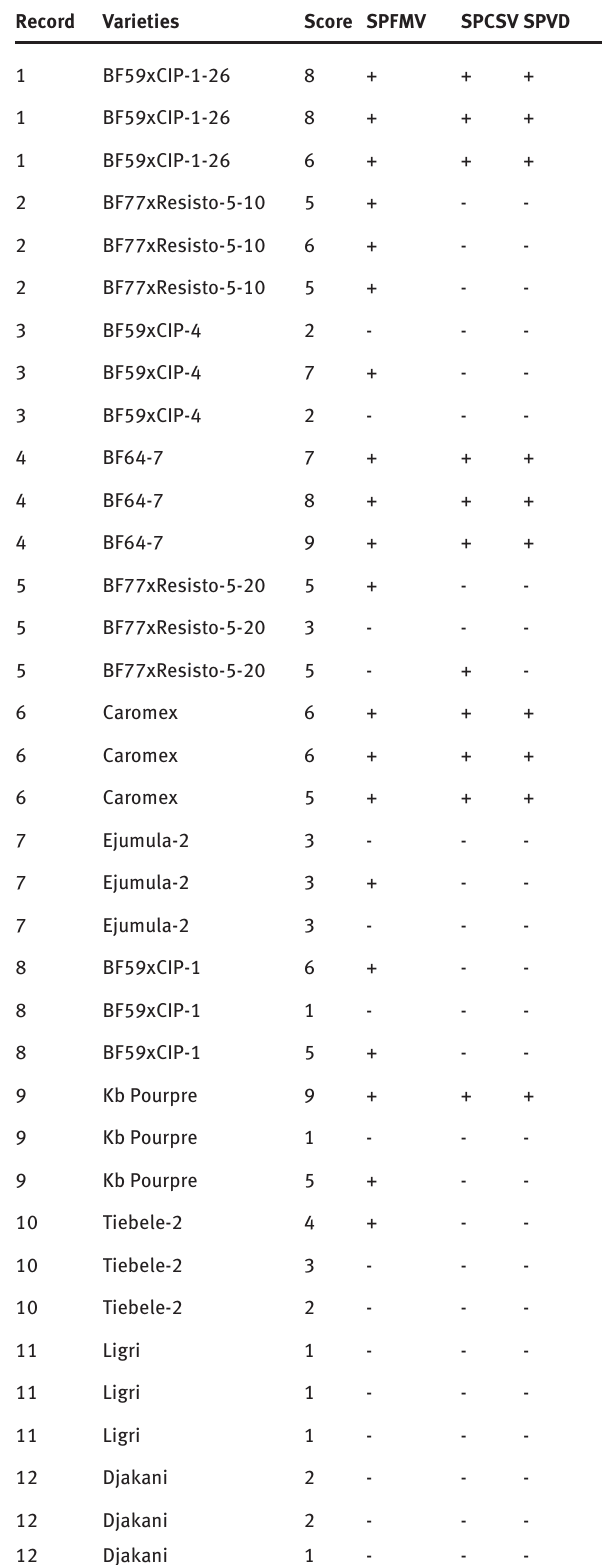
Table 1: RT-PCR diagnostic results of evaluated varieties